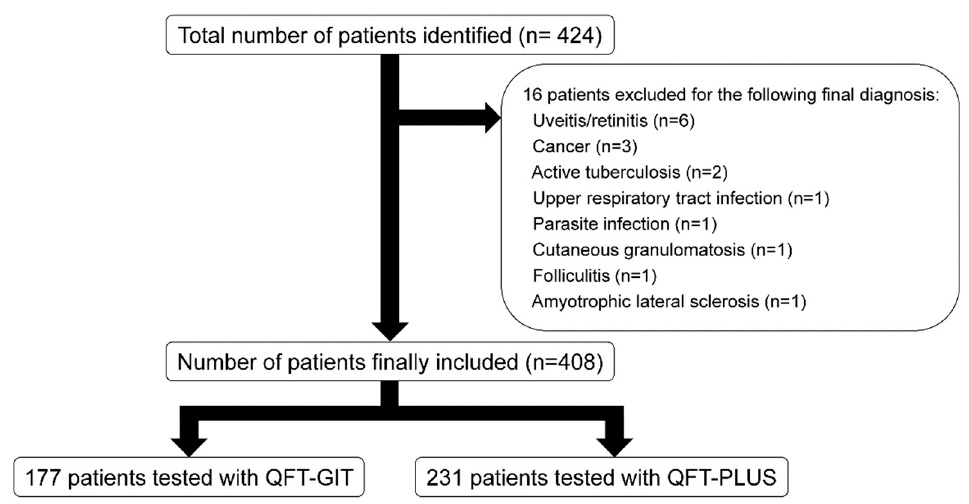
Figure 1. Patient selection and exclusion. QFT-GIT: QuantiFERON-TB Gold In-Tube; QFT-PLUS: QuantiFERON-TB Gold PLUS.